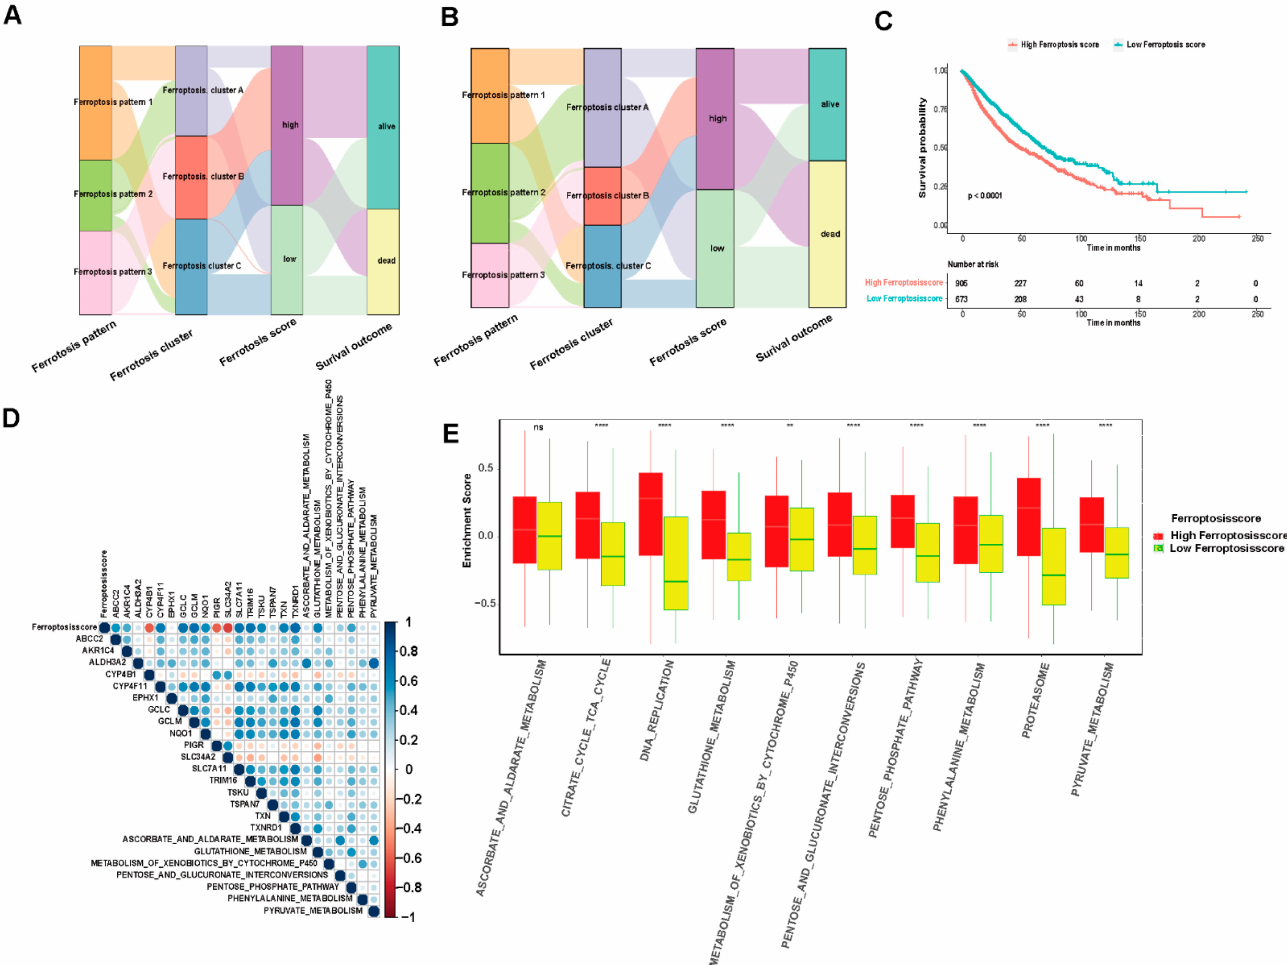
Figure 6. The ferroptosis score construction. ( A , B ). Alluvial diagram shows the ferroptosis pattern changes, including ferroptosis-related gene clusters and ferroptosis score groups and survival out- comes. ( C ) Kaplan–Meier plot for OS in the high and low ferroptosis score groups. Kaplan–Meier curves indicate that the ferroptosis score was markedly related to OS of 1578 patients in the LUAD and LUSCC cohort, of which 905 cases were in the high ferroptosis score group and 673 cases were in the low ferroptosis score group ( p < 0.0001, log-rank test). ( D ) The correlation between the high and low ferroptosis score groups and known gene characteristics in LUAD and LUSCC. Blue represents negative correlation and red represents positive correlation. ( E ) Differences in 10 enrichment path- ways between high ferroptosis score and low ferroptosis score groups (ns, not significant; ** p < 0.01; **** p <